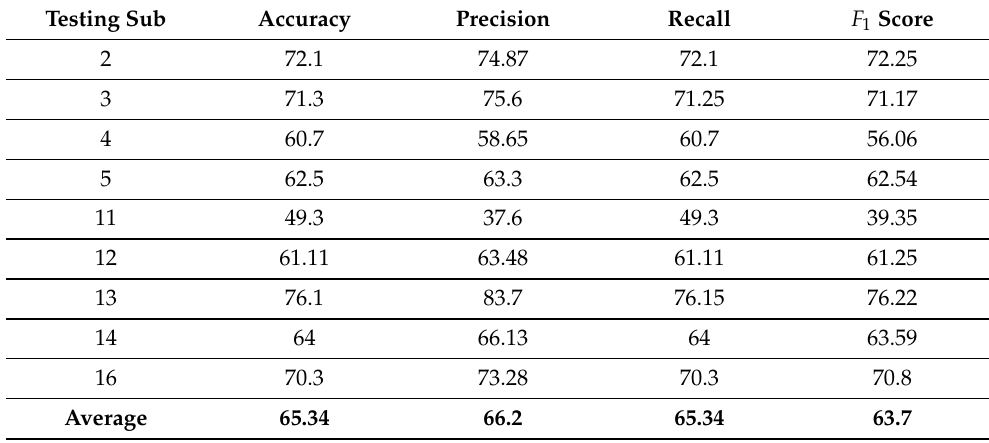
Table 5. Accuracy, precision, recall and F 1 score using 2D spectrograms of RML data with